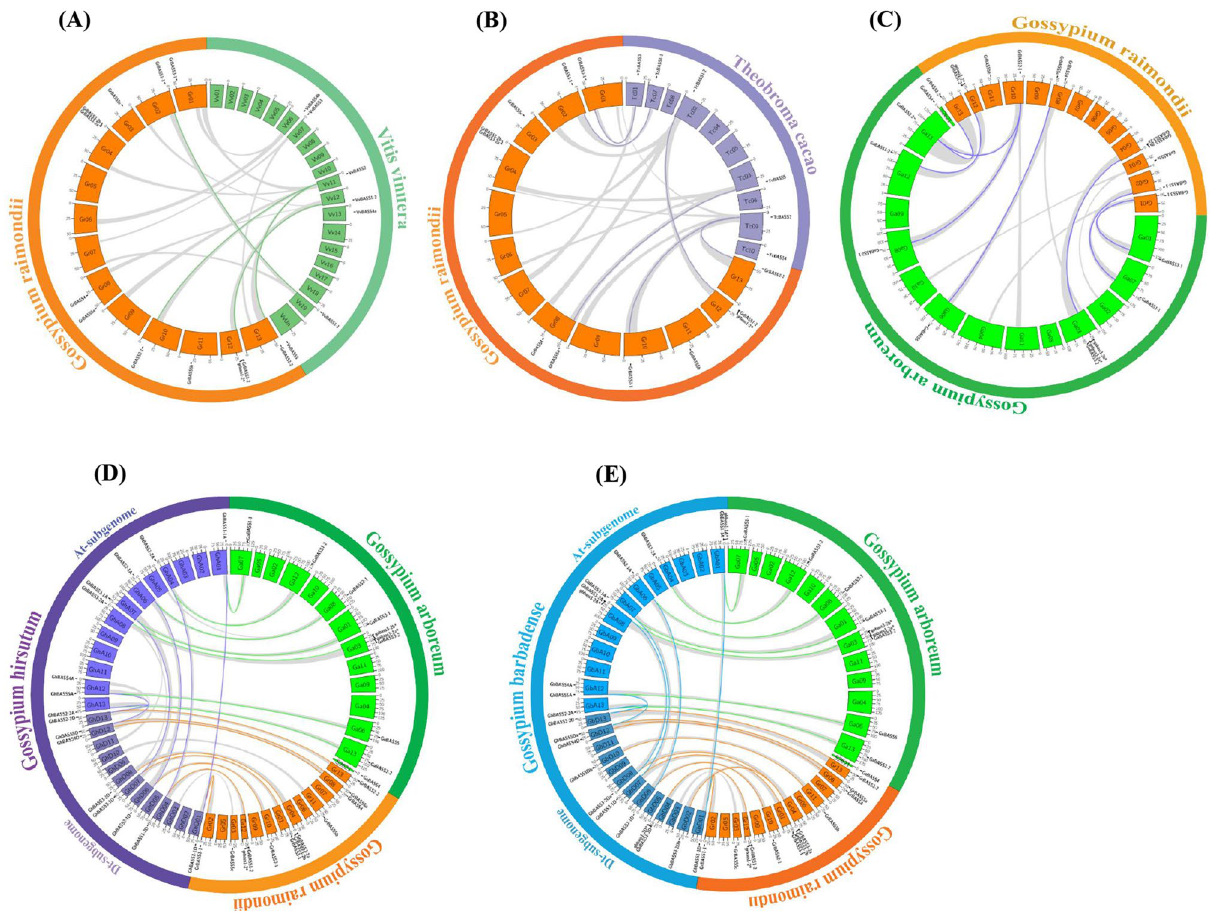
Figure 4. Genome-wide synteny analysis of BASS genes employing the MCScanX software. ( A ) Synteny analysis between G. raimondii and V. vinifera. Orange and green colored bars were depicted as chromosomes of G. raimondii (Gr01–13) and V. vinifera (Vv01–19 and VvUn), respectively. Green lines link orthologous gene pairs between G. raimondii and V. vinifera. ( B ) Synteny analysis between G. raimondii and T. cacao . Chromosomes of G. raimondii (Gr01–13) and T. cacao (Tc01–10) were filled with orange and purple, respectively. Purple lines connect orthologous gene pairs between T. cacao and G. raimondii. ( C ) Synteny analysis between G. arboreum and G. raimondii . Chromosomes of G. raimondii (Gr01–13) and G. arboreum (Ga01–13 and scaffold2621) were filled with orange and green, respectively. Blue lines bridge orthologous gene pairs between G. arboreum and G. raimondii. ( D ) Synteny analysis between G. hirsutum and two diploid species ( G. arboreum and G. raimondii ) . Purple, orange and green colored bars were depicted as chromosomes of G. hirsutum (GhA01–13 and GhD01–13), G. raimondii (Gr01–13) and G. arboreum (Ga01–13 and scaffold2621), respectively. Green lines link orthologous gene pairs between G. arboreum and G. hirsutum, orange lines connect orthologous gene pairs between G. raimondii and G. hirsutum, and purple lines bridge homoeologous gene pairs between At- and Dt-subgenome of G. hirsutum. ( E ) Synteny analysis between G. barbadense and two diploid species ( G. arboreum and G. raimondii ) . Blue, orange and green colored bars were depicted as chromosomes of G. barbadense (GbA01–13 and GbD01–13), G. raimondii (Gr01–13) and G. arboreum (Ga01–13 and scaffold2621), respectively. Green lines link orthologous gene pairs between G. arboreum and G. barbadense, orange lines connect orthologous gene pairs between G. raimondii and G. barbadense , and blue lines bridge homoeologous gene pairs between At- and Dt-subgenome of G. barbadense. Grey lines represent conserved synteny blocks between two different genomes and/or subgenomes of species. Putative BASS family genes were anchored to their corresponding chromosomes, and the symbol (*) means